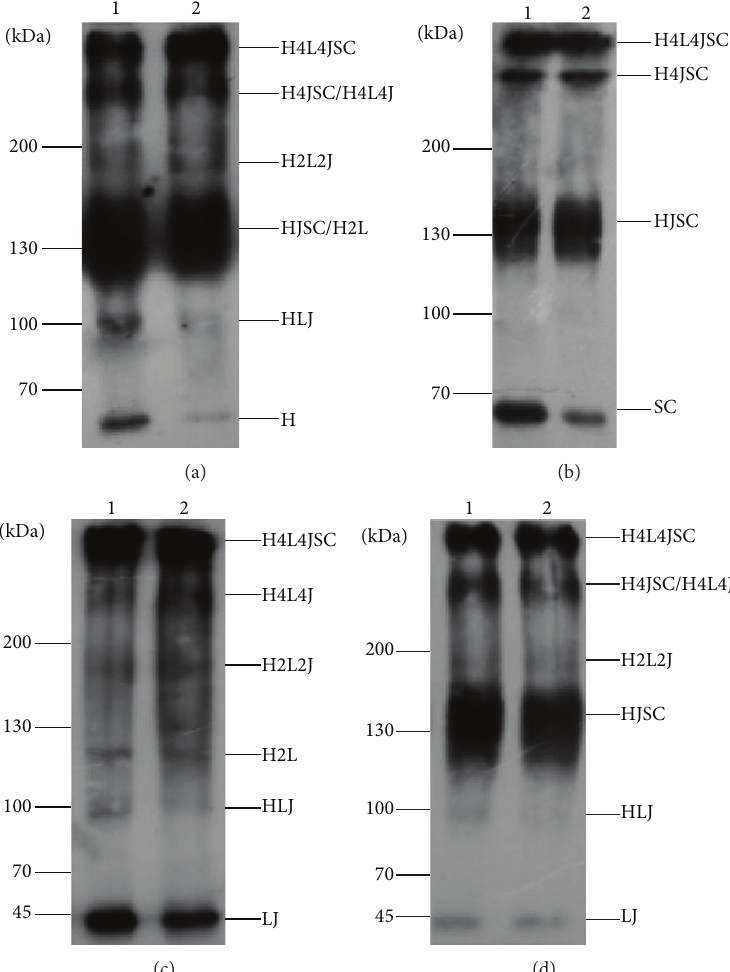
Figure 4: Western blot analysis of recombinant SIgA under nonreducing conditions. Transferred proteins were incubated with different primary antibodies to confirm the various polymeric forms of recombinant SIgA. (a) Mouse anti-human IgA 𝛼 -chain antibody. (b) Mouse anti-human SC antibody. (c) Mouse anti-human 𝜅 -chain antibody. (d) Mouse anti-human J chain antibody. HRP-conjugated goat anti- mouse IgG was used as secondary antibody. Lane 1: produced SIgA; 2: human saliva (positive control). H4L4JSC (complete SIgA molecule), H4JSC/H4L4J (four IgA 𝛼 -chains, J chain, and secretory component or four IgA 𝛼 -chains, four 𝜅 -chains, and J chain), HJSC/H2L (one IgA 𝛼 -chain, J chain, and secretory component or two IgA 𝛼 -chains and one 𝜅 -chain), HLJ (one IgA 𝛼 -chain, one 𝜅 -chain, and J chain), LJ (one 𝜅 -chain and J chain), and H or SC (monomer of IgA 𝛼 -chain or secretory component).